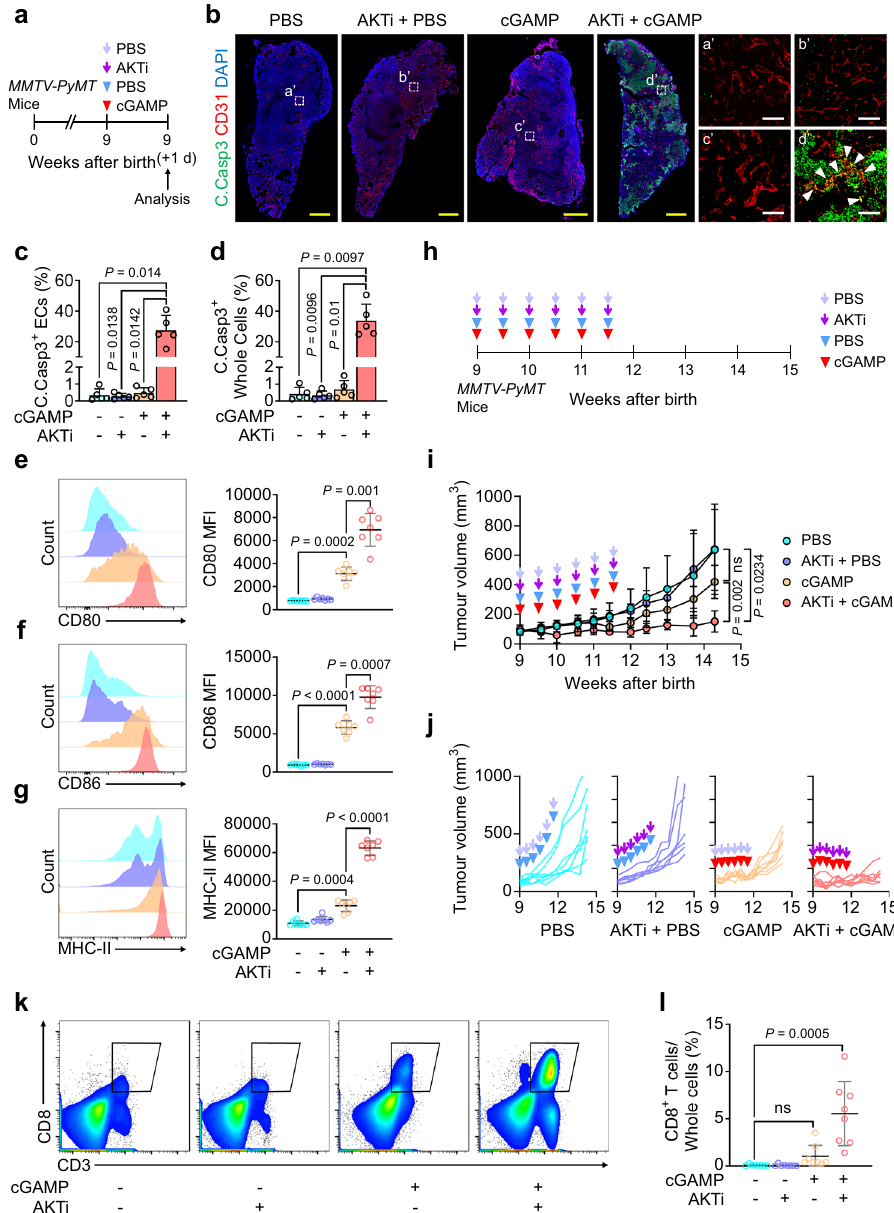
Fig. 10 AKT inhibitor potentiates STING activation-induced tumour EC apoptosis and anti-tumour effect in MMTV-PyMT spontaneous breast cancer. a – g Diagram depicting treatment and tumour sampling in MMTV-PyMT mice. b – d, Representative images of tumour vessels and apoptosis. Each dotted- line box region is magni fi ed and displayed in right panels. White arrowheads indicated tumour EC apoptosis. Scale bars, 1.0;mm (yellow bars) and 100 μ m (white bars). Comparisons of apoptosis of tumour ECs and whole tumour cells. Each dot indicates a value from one mouse and n = 5 mice/group from four independent experiments ( c , d ). Vertical bars indicate mean ± SD. e – g Representative fl ow cytometry plots and comparisons of CD80, CD86, and MHC-II expression on the DCs in each TDLN. Each dot indicates a value from one mouse and n = 7 mice/group from four independent experiments ( e – g ). Horizontal bars indicate mean ± SD. h – j Diagram depicting treatment schedule in MMTV-PyMT mice. Comparisons of tumour growths. n = 7 mice/group from four independent experiments. Vertical bars indicate mean ± SD. Plots indicate each individual tumour growth. k , l AKTi or cGAMP was injected twice with 3-day interval in 9-week-old MMTV-PyMT mice and tumours were sampled 1 week later. Representative fl ow cytometry plots and comparison of CD8 + T cells. Each dot indicates a value from one mouse and n = 8 mice/group from four independent experiments. Horizontal bars indicate mean ± SD. P values by Welch ’ s one-way ANOVA test followed by Dunnett ’ s T3 test ( c – g , i ) or Kruskal – Wallis test followed by Dunn ’ s test ( l ). ns, not signi fi cant. Source data are provided as a Source Data fi AKTi alone did not induce apoptosis in tumour ECs and whole AKT activation plays a central role in survival in several cell tumour cells in spontaneous tumours. We hypothesized that AKT types, including ECs 26 – 28 . Our analysis actually revealed that the tumour ECs of human breast ductal adenocarcinomas retain inhibition might enforce STING activation-induced apoptosis of highly phosphorylated AKT compared with the ECs in adjacent tumour ECs in primary tumours based on our RNA-seq data normal tissue region. Nevertheless, our fi ndings indicate that and a previous report 43 . Indeed, AKTi treatment abrogated